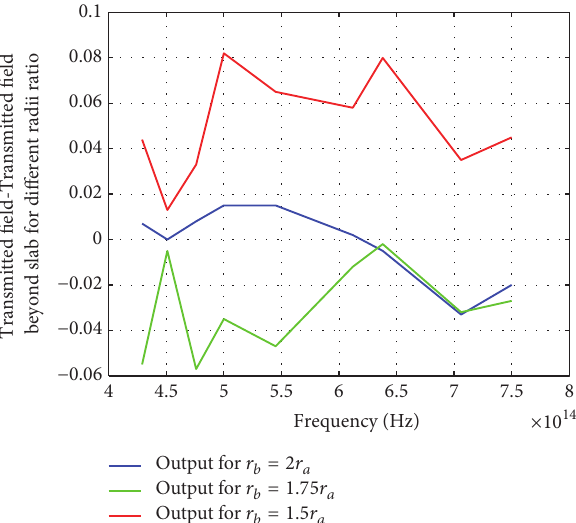
Figure 6: Plots for transmitted field-transmitted field beyond slab versus frequency for different radii